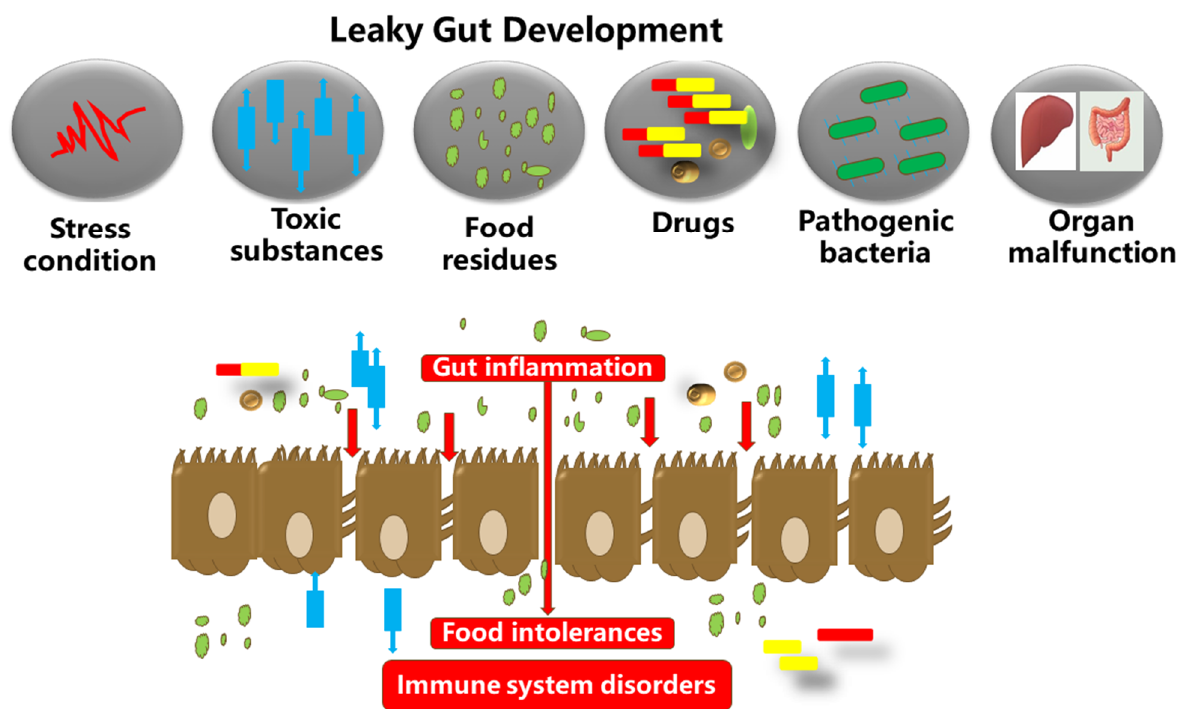
Figure 5. The gut microbiota, food substances, and the gut epithelium are in proximity. Dysbiosis in the gut microbiota could inversely increase the gut permeability. This results in autoimmune and neurodegenerative disorders, and excessive inflammation in the gut epithelium, which in turn degenerates the tight junction proteins and membranes (occludin, claudins, junctional adhesion molecules, and tri-cellulin, ZO-1, and cingulin). The tight junction barriers are disrupted by the invasion of toxic substances (bacterial endotoxins, metabolites, food particles, drugs, etc.), resulting in barrier dysfunction and severe inflammatory disorders such as IBDs.